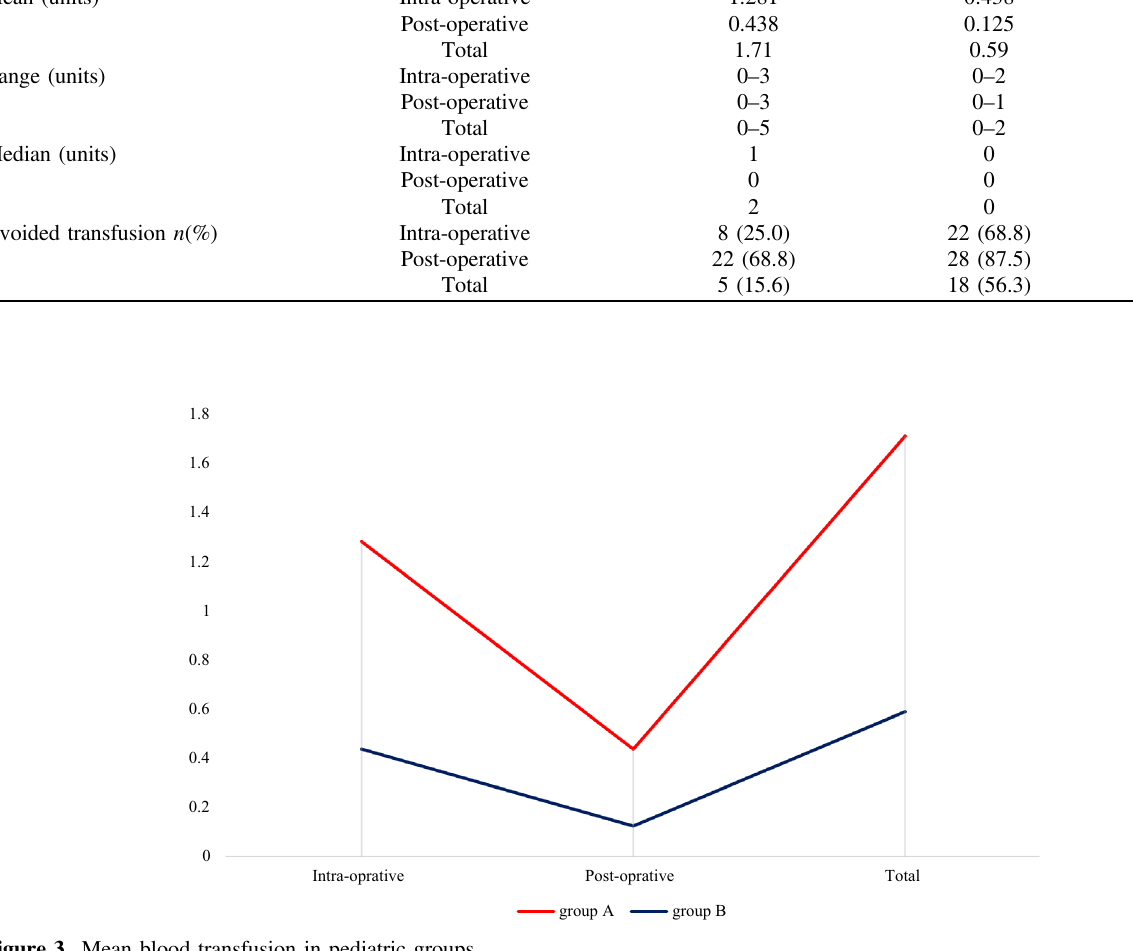
Figure 3. Mean blood transfusion in pediatric groups.